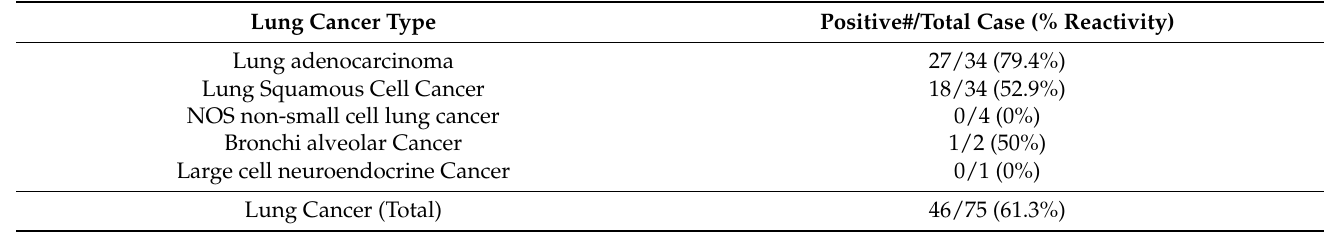
Table 2. NEO-201 IHC profile: results from lung cancer